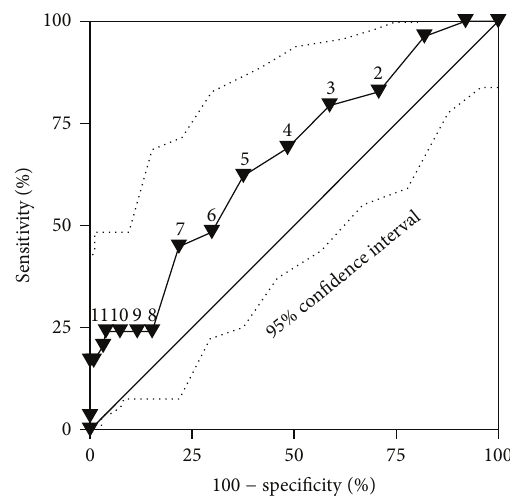
Figure 2: Receiver operating characteristic (ROC) curve for the HADS-depression subscale. Solid triangles indicate different cut-off scores for diagnosing depression.